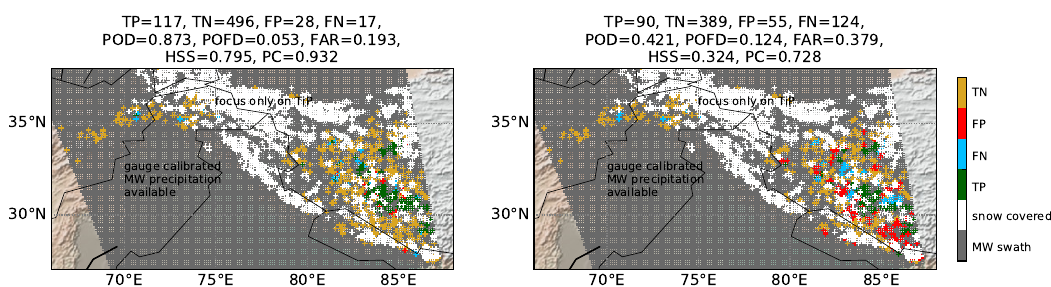
Figure 8. Comparison of the performance of the new precipitation area delineation (left) with IMERG’s IR only, both with reference to IMERG’s gauge calibrated MW precipitation on July 7th 2017 on 4:00 p.m. UTC. These estimates are available for the grey MW swath marked area. Snow covered areas do not fulfill the quality index from